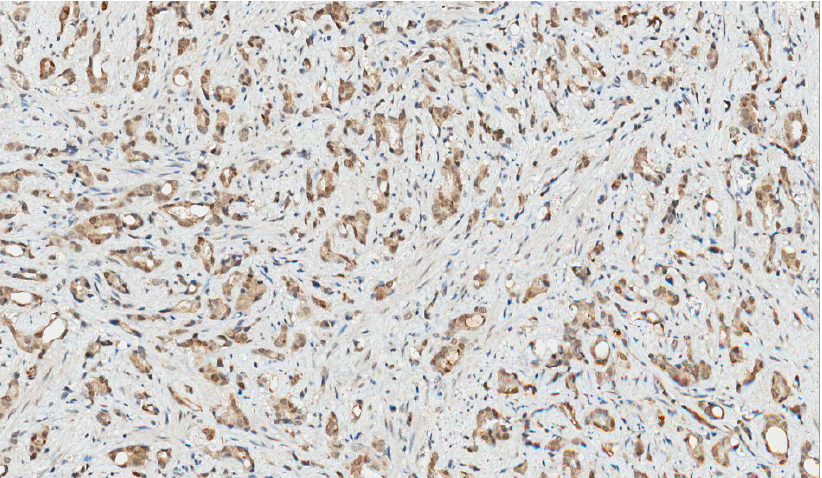
Figure 3. VEGF staining in prostate cancer tissue. Strong brown cytoplasmic staining for VEGF in prostate cancer cells, 200× magnification.